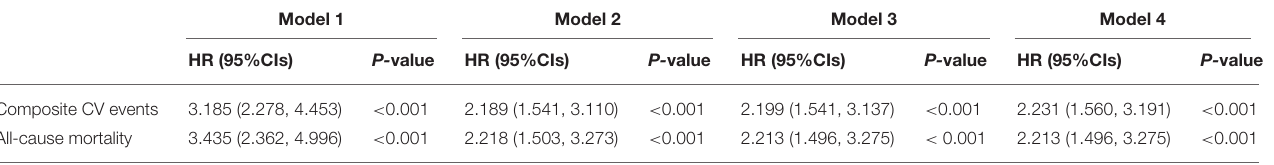
TABLE 3 | Cox regression analysis of LVDD ( E / e ′ > 14) for clinical outcomes using multiple imputations.